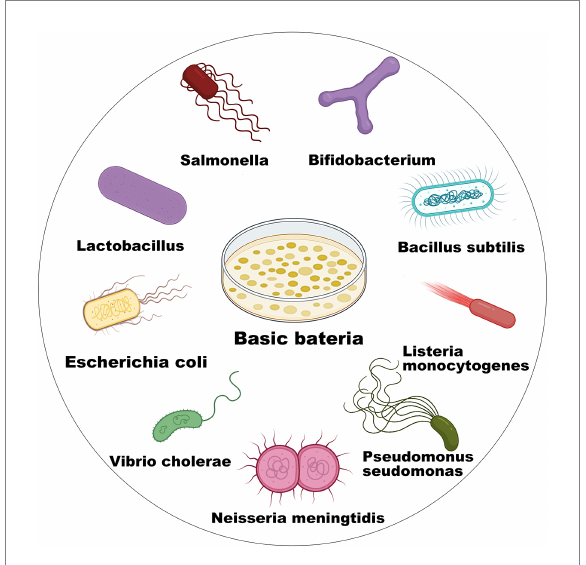
FIGURE 1 Microbial chassis for GEB